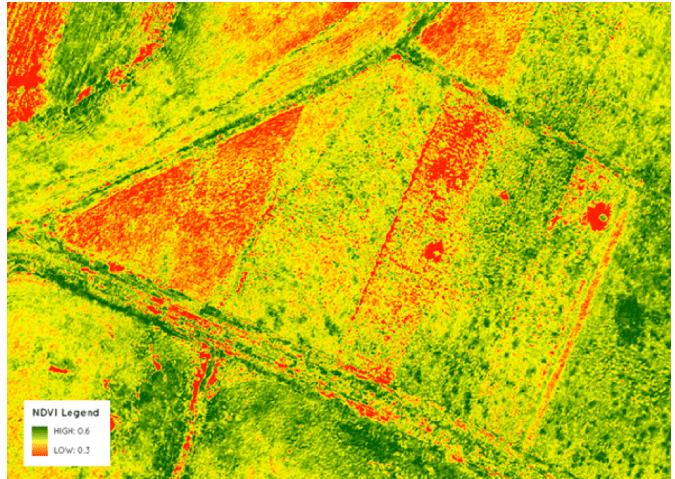
Figure 3. Characterization of the NDVI with low cost solutions